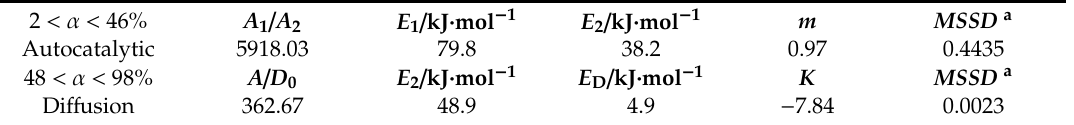
Table 2. Parameters obtained by fitting Equations (15) and (17).